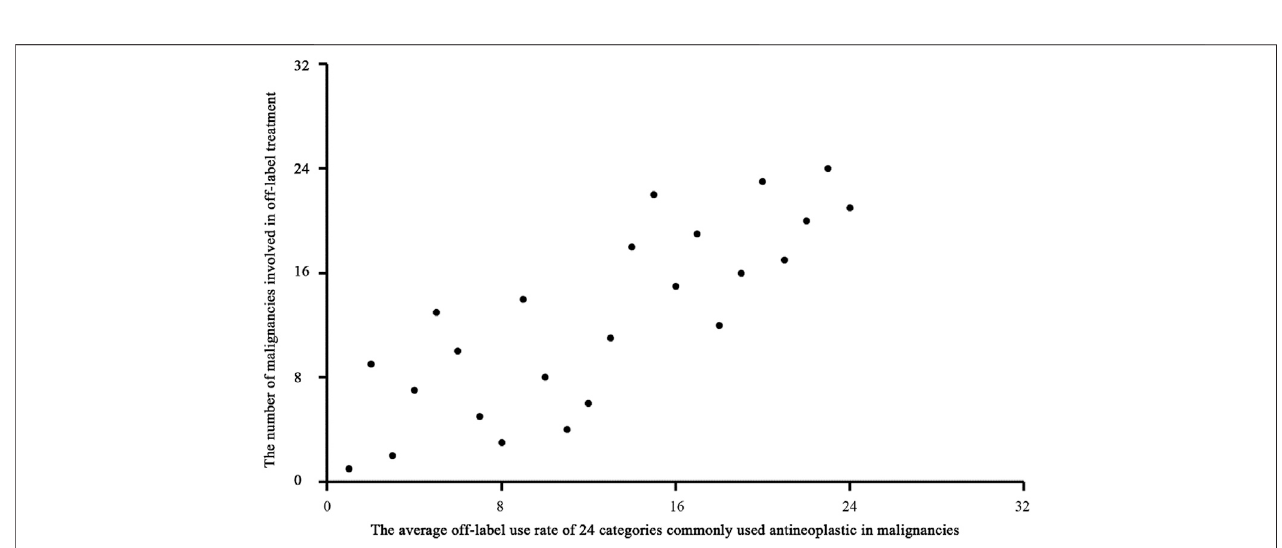
FIGURE 4 | Scatter diagram of the average OL use rate of antineoplastic drugs and the number of malignancies treated using OL drugs.